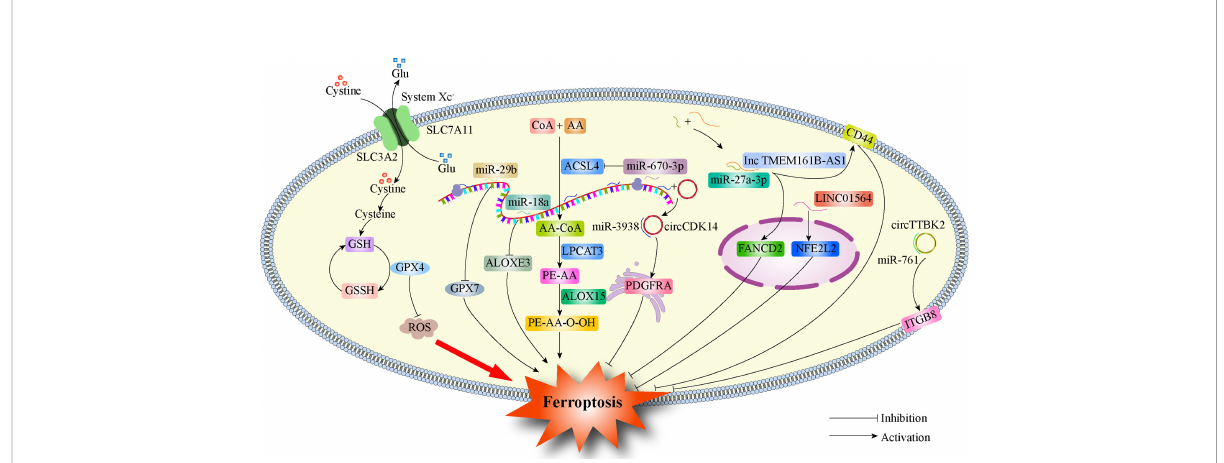
FIGURE 2 Regulation of ferroptosis by ncRNAs in glioma. GPX4, Glutathione Peroxidase 4; SLC7A11, Solute carrier family 7 membrane 11; SLC3A2, Solute carrier family 3 membrane 2; GPX7, Glutathione Peroxidase 7; ACSL4, Acyl-CoA synthetase long-chain family member 4; ALOXE3, Arachidonate lipoxygenase 3; PDGFRA, Platelet-derived growth factor receptor; FANCD2, FA Complementation Group D2; CD44, Cluster of differentiation 44; NFE2L2, Nuclear factor erythroid 2-like 2; ITGB8, Integrin subunit beta 8.